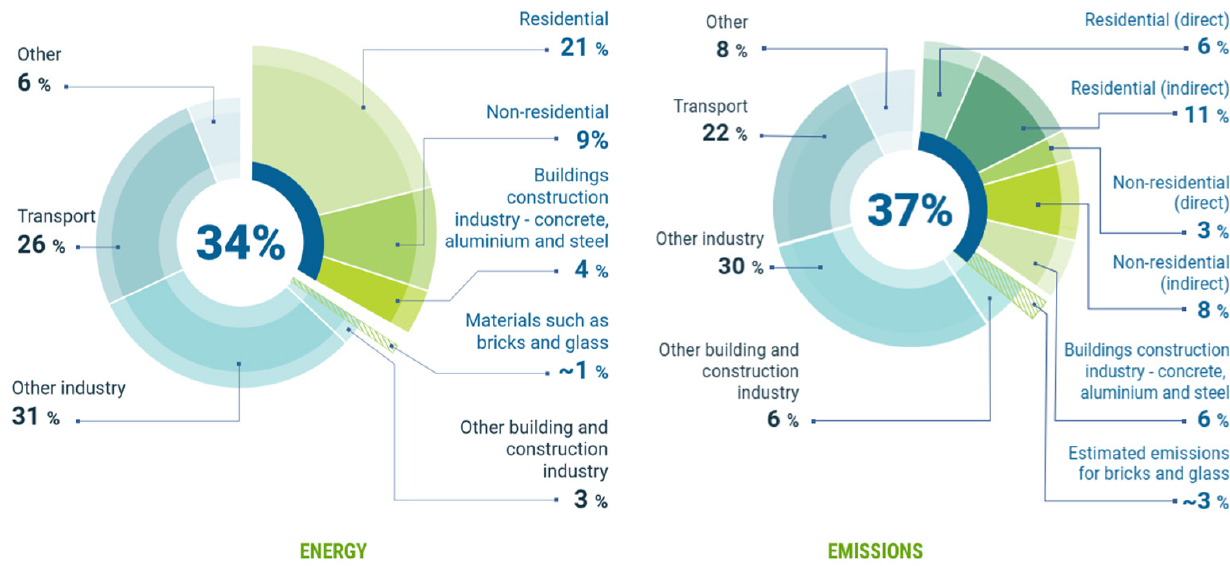
Figure 1. Buildings and construction’s share of global final energy and energy-related CO 2 emissions, 2021. Adapted from [6]. Note: numbers in pie charts are rounded figures and should not be summed up to calculate total values.